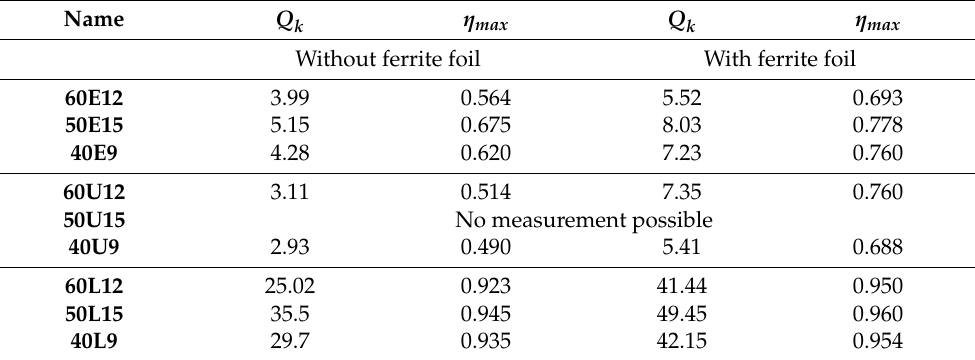
Table 7. Results for transmission quality Q k and maximum efficiency η max of test series S.